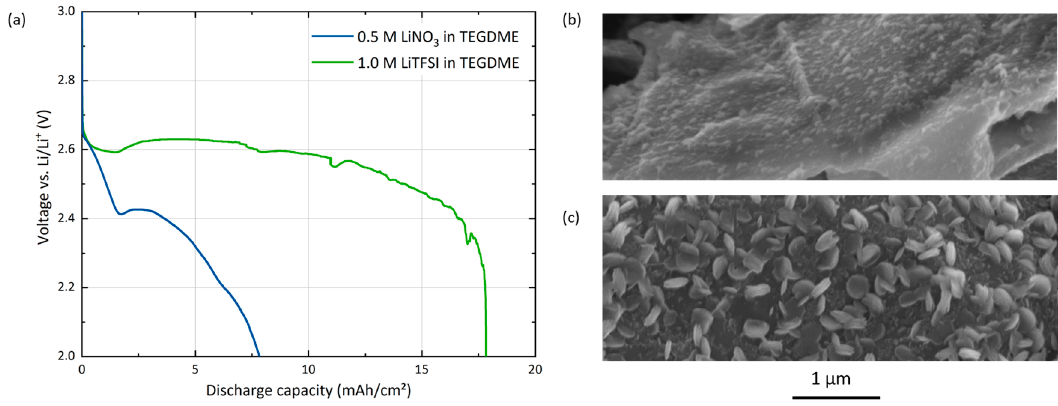
Figure 4. ( a ) Discharge profiles at 150 µA/cm 2 with GNS-foams and 200 µL of 0.5 LiNO 3 or 1.0 M LiTFSI. SEM of characteristic discharge products on GNS for ( b ) LiTFSI and ( c ) LiNO 3 .